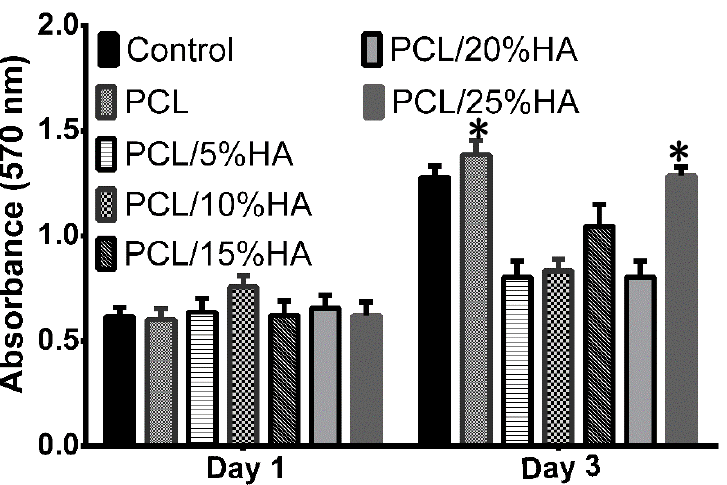
Figure 4. Cell proliferation results of MC3T3-E1 cells after culturing for 1 and 3 days on the PCL/HA scaffolds with 0% − 25% HA content. * p < 0.05 vs. Control.